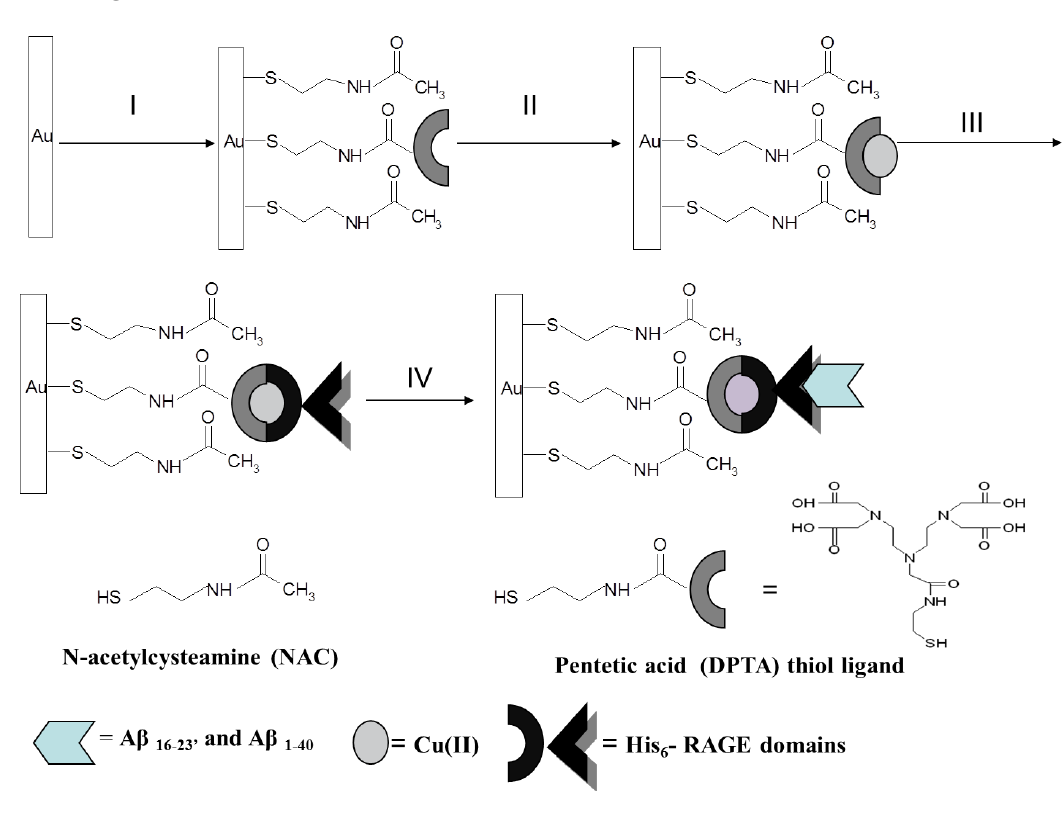
Figure 1. The scheme of the biosensor based on NAC/DPTA–Cu(II)